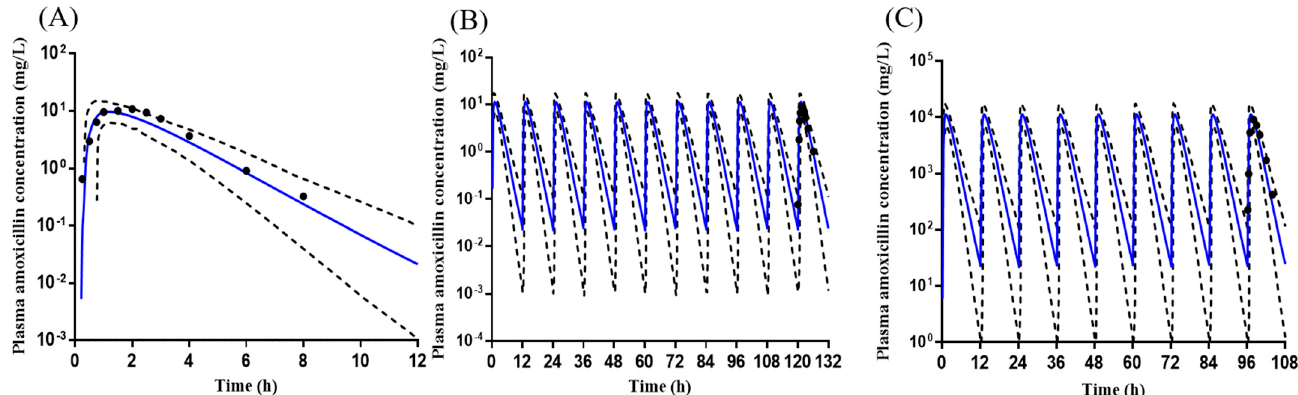
Figure 3. The mean observed (black dot) and predicted (solid blue line, n = 100) plasma concentration–time profiles of amoxicillin. ( A ) Administration of a single 875 mg amoxicillin tablet, observed n = 10 [21]; ( B ) administration of 1000 mg amoxicillin twice daily for 6 days, observed n = 15 [22]; ( C ) administration of 1000 mg amoxicillin twice daily for 5 days, observed n = 20 [11]. The solid gray lines represent the 5th and 95th percentiles. The observed data were adapted from references [11,21,22].